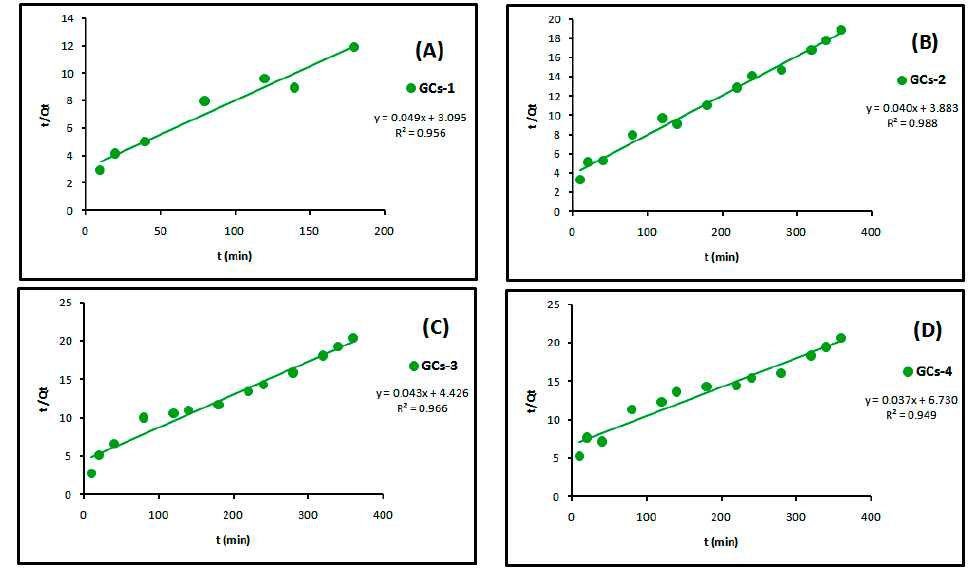
Figure 12. Pseudo-second order kinetics models of nickel adsorption using ( A ) GCs-1; ( B ) GCs-2; ( C ) GCs-3 and ( D ) GCs-4.